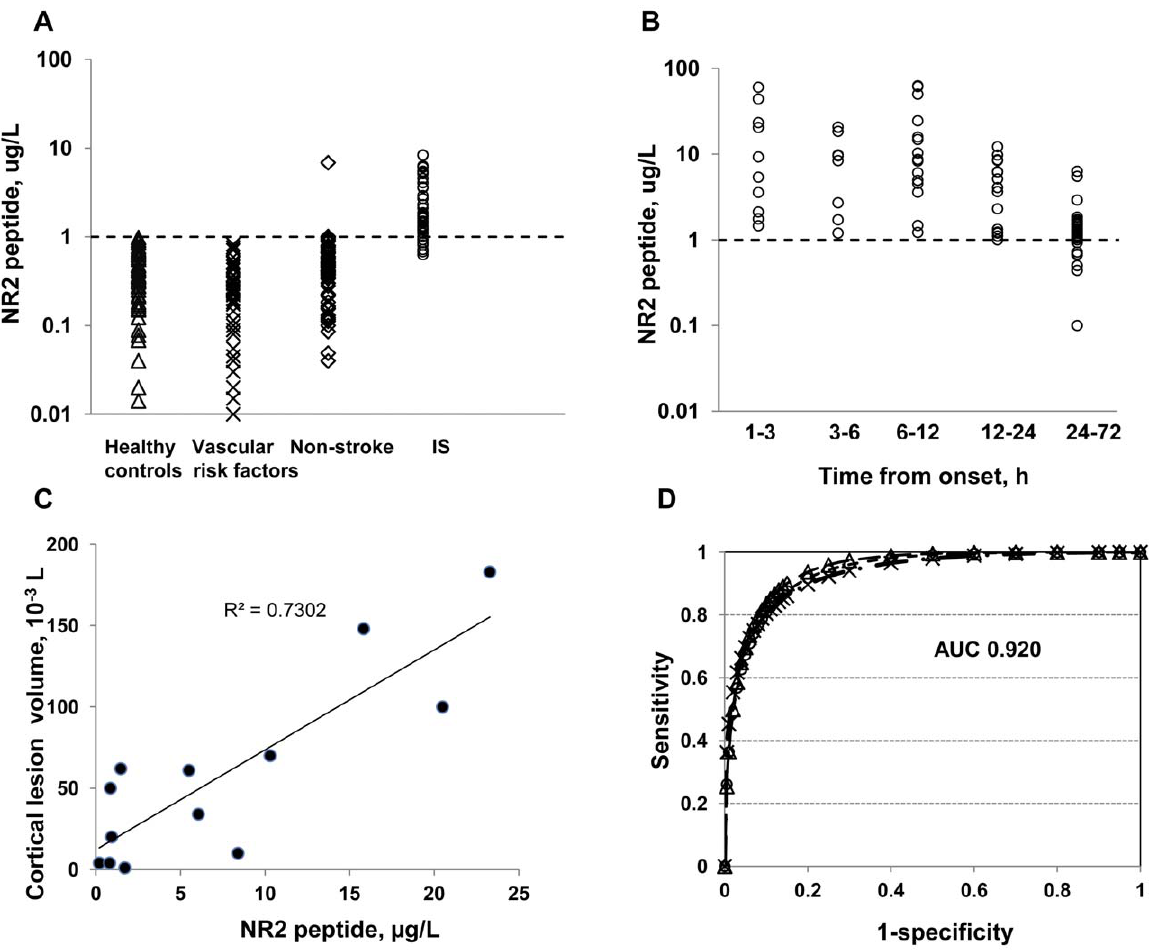
Figure 2. Distribution of plasma NR2 peptide concentrations in (A) healthy controls (n=52), persons with controlled vascular risk factors (n=48), non-stroke (n=99) and acute ischemic stroke (n=101). Distribution of NR2 peptide in plasma of patients with acute IS depending on time of symptom onset: n=10 at 1–3 h, n=8 at 3–6 h, n=15 at 6–12 h, n=17 at 12–24 h, and n=51 at 24–72 h ( B ). Correlation of NR2 peptide concentrations with new cortical lesion ( C ). ROC curves for plasma NR2 peptide depended comparison group ( D ). Areas under the each curve are 0.930 calculated for the biomarker potential to distinguish acute IS vs certain control group, 0.914 for acute IS vs non-stroke, and 0.920 for acute IS vs combined control and non-stroke groups.